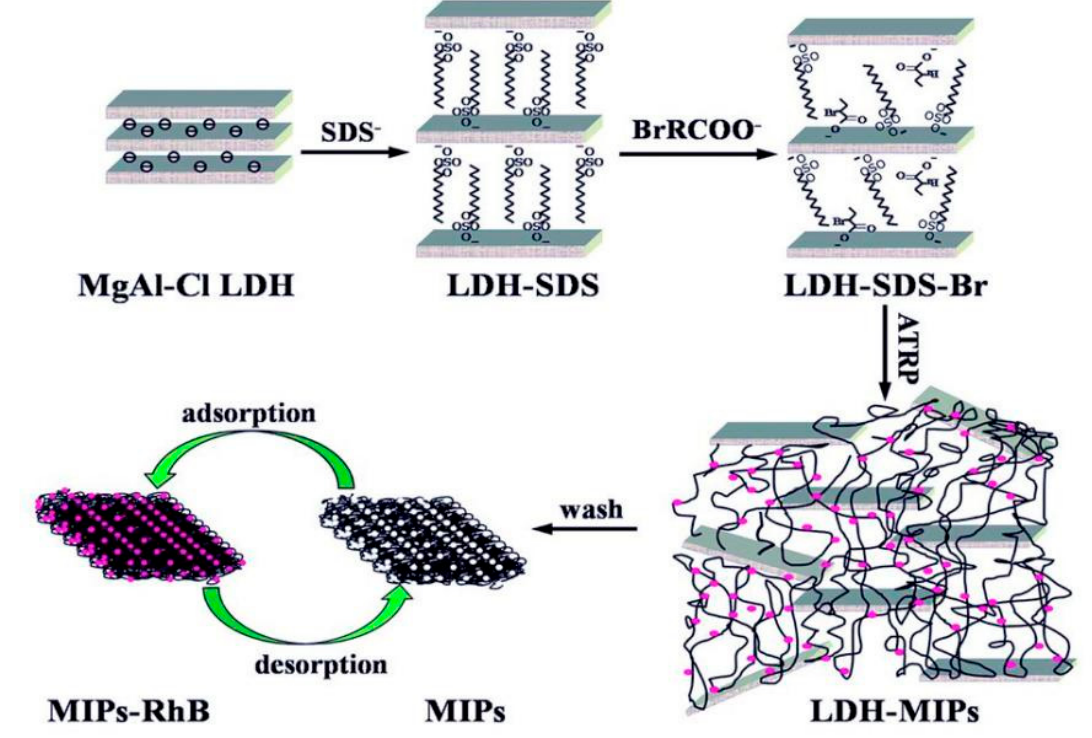
Figure 18. Preparation of ultra-thin MIPs membranes for RhB. Reproduced with permission from ref. [84].